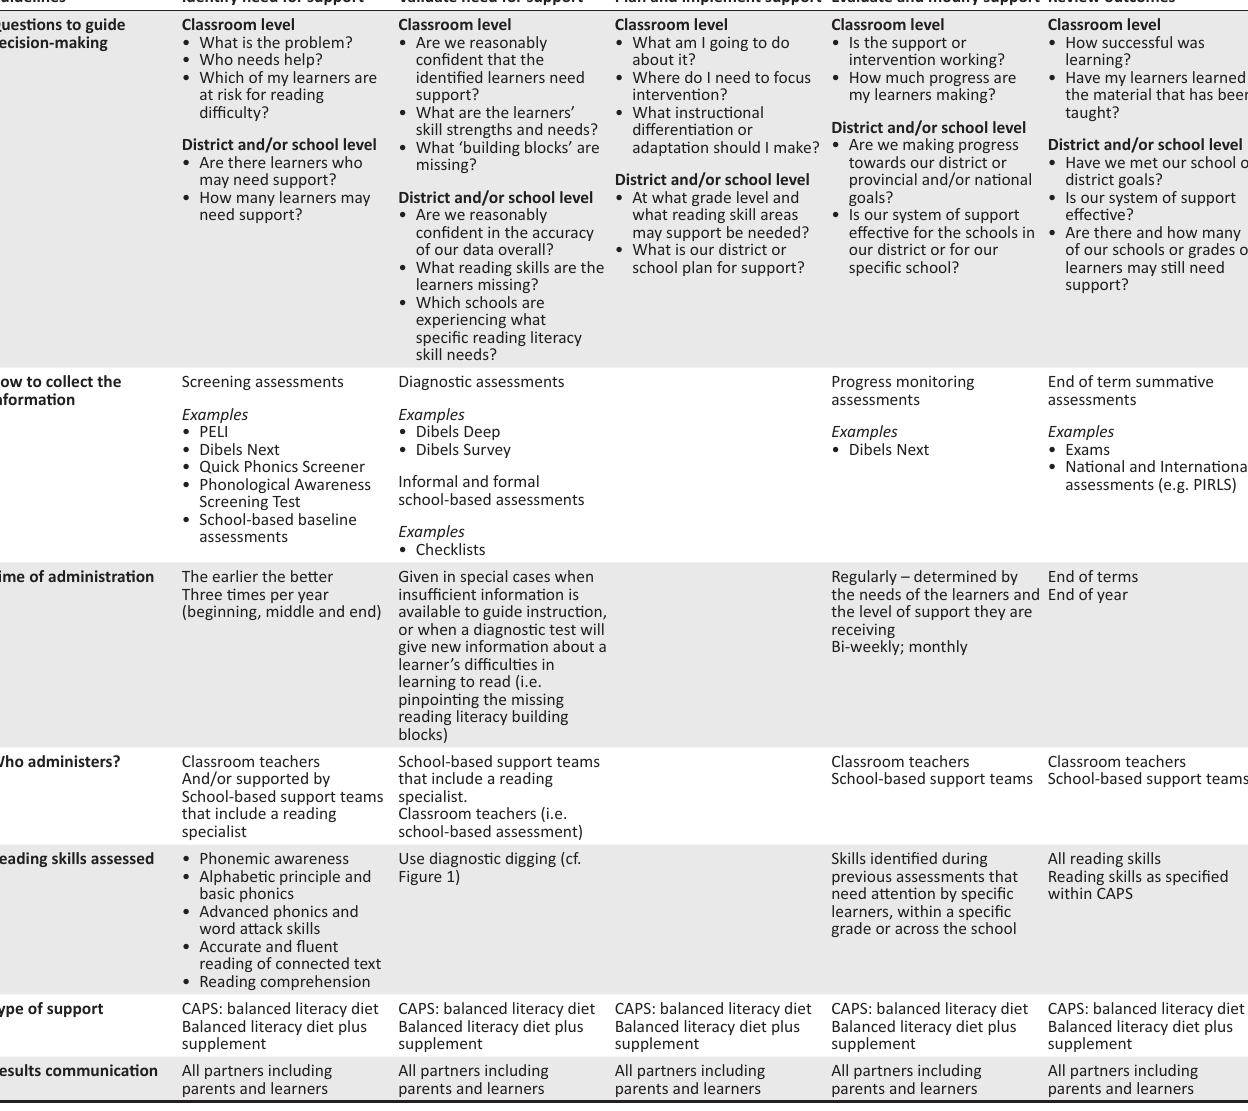
TABLE 1: Blueprint for data-based English reading literacy planning, decision- making and